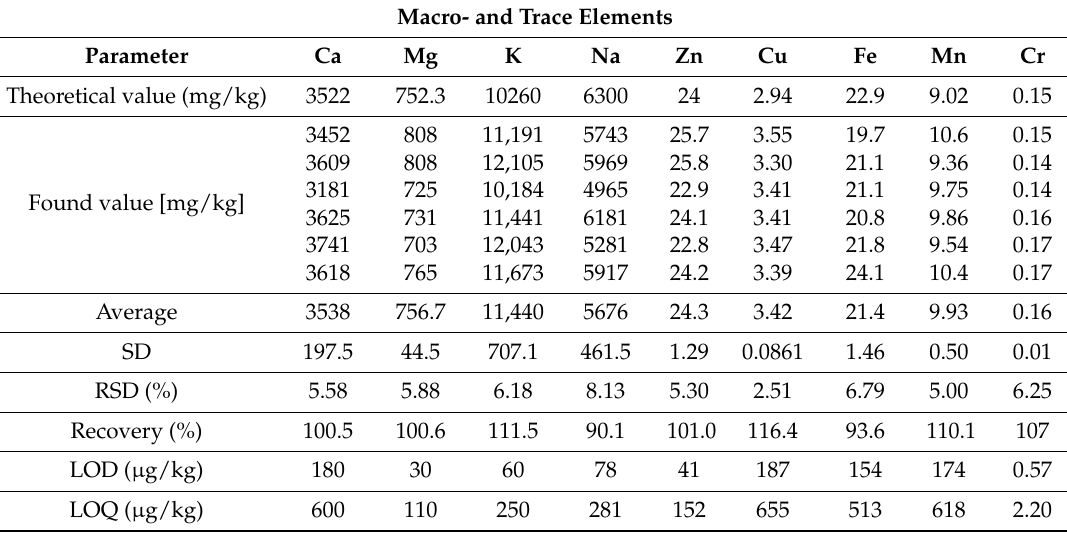
Table 4. Concentration of macro- and trace elements in the reference